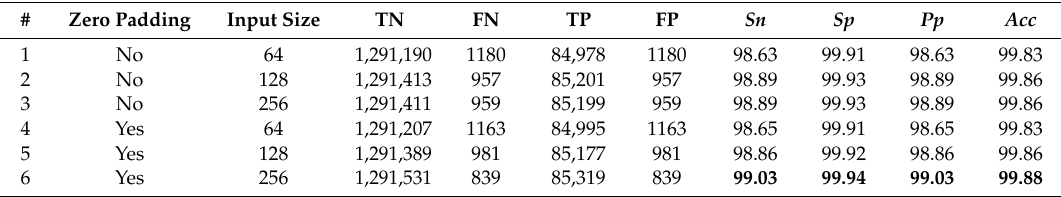
Table 4. E ff ect of zero padding on various input sizes.